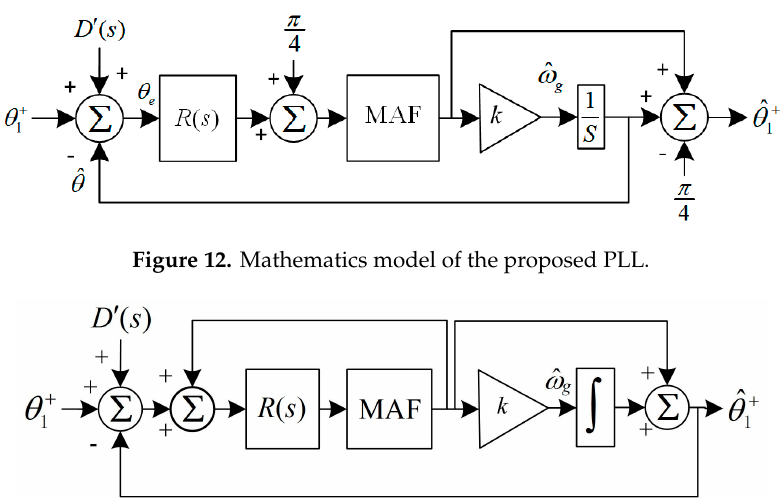
Figure 13. Simplified model of the proposed PLL.